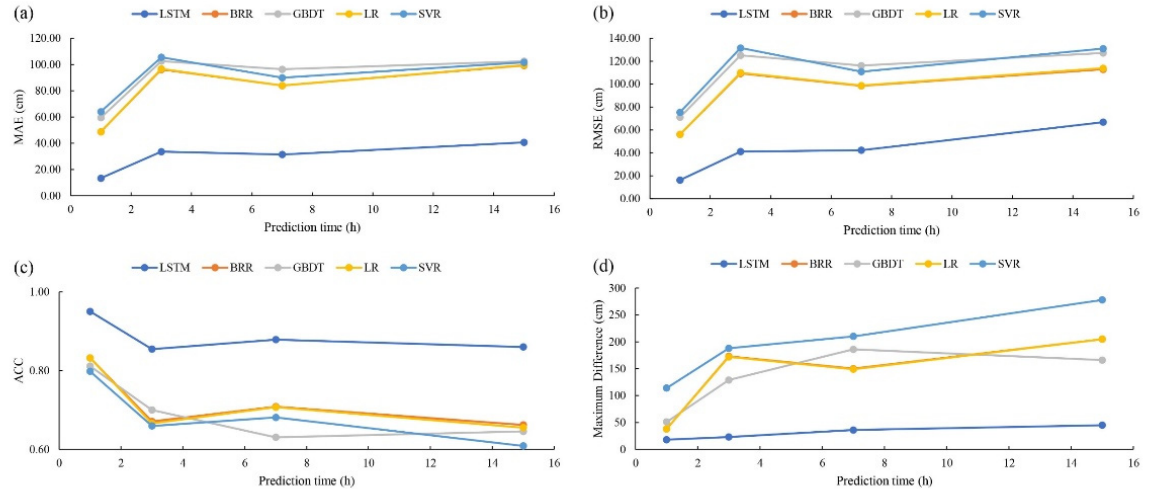
Figure 8. Model evaluation of testing set for ( a ) MAE, ( b ) RMSE, ( c ) ACC, and ( d ) Maximum Difference with 1 h, 3 h, 7 h, and 15 h prediction times.